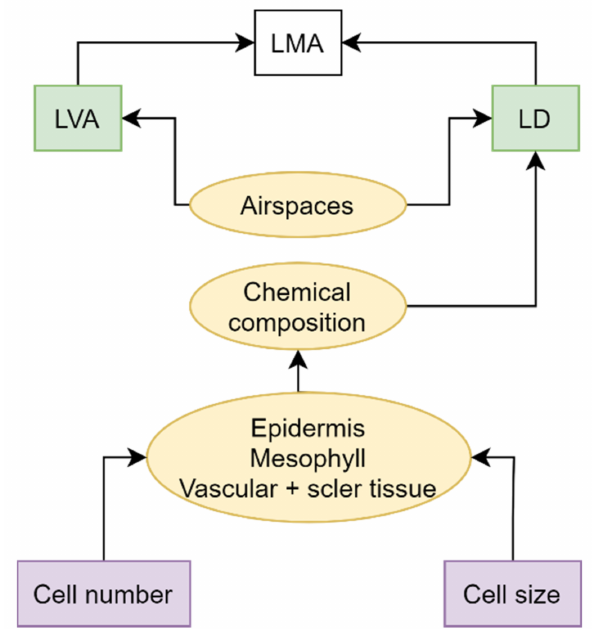
Figure 1. Anatomical variation in leaf characteristics at cell (purple), tissue (yellow), and leaf (green) levels that govern variation in LMA. Vascular + scler tissue = vascular tissue plus sclerenchymatous tissue. Adapted from